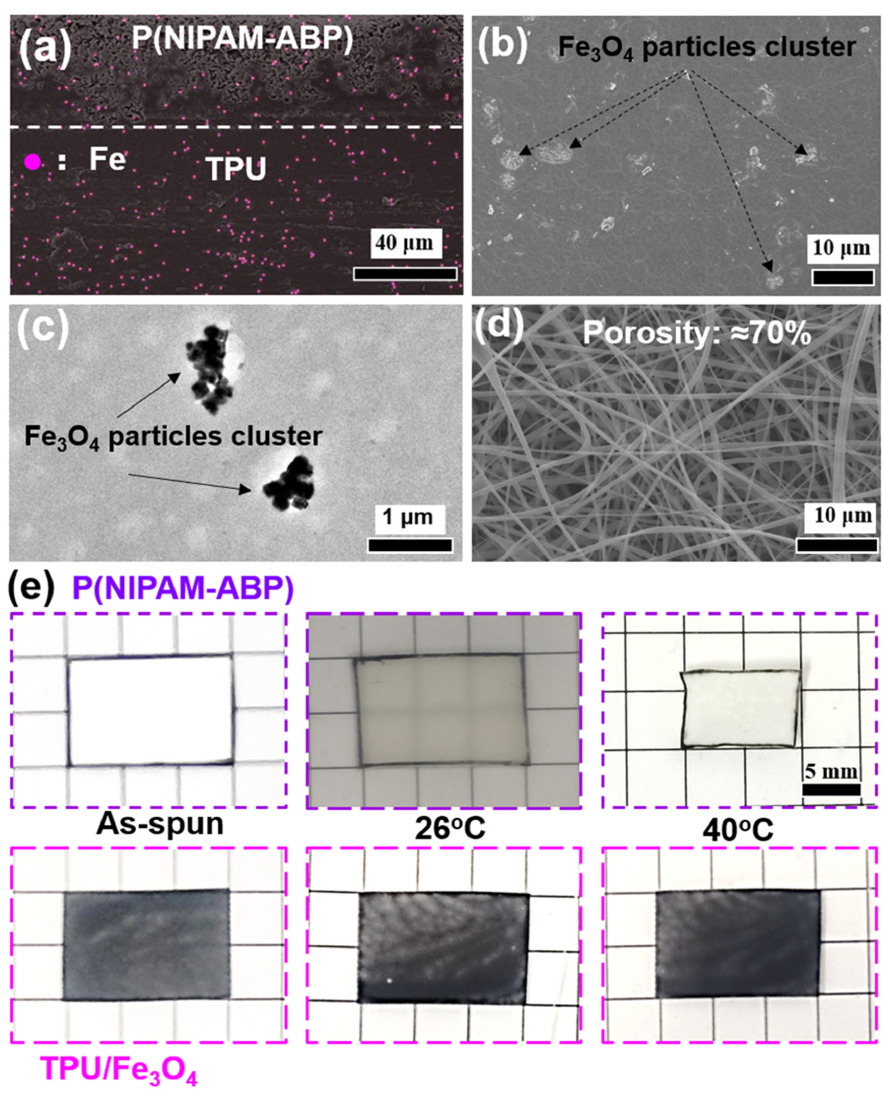
Figure 2. Morphology of the composite actuator. ( a ) The EDS mapping of the cross-section of the actuator, the pink dots indicate the Fe element; the SEM and TEM images of the TPU/Fe 3 O 4 particles side were shown in ( b , c ), respectively; ( d ) the SEM image of the P(NIPAM-ABP) fibrous mat; ( e ) size changes of P(NIPAM-ABP) electrospun fibrous mat (white) and TPU/Fe 3 O 4 film (black) in water with different temperatures.